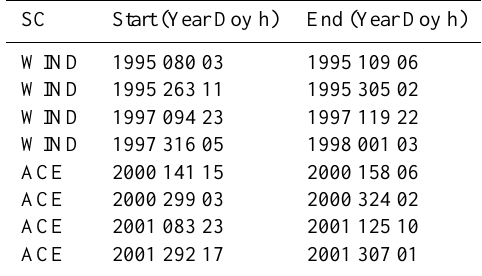
Table 2. The EDDA training